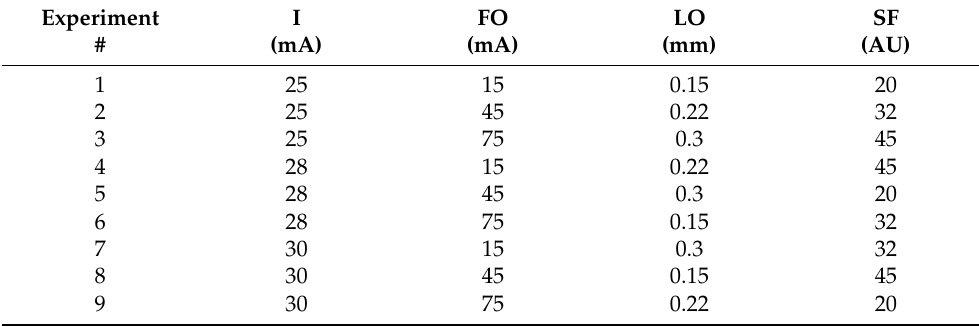
Table 2. Experimental design as per L9 orthogonal array. Each row represents a parameter set.